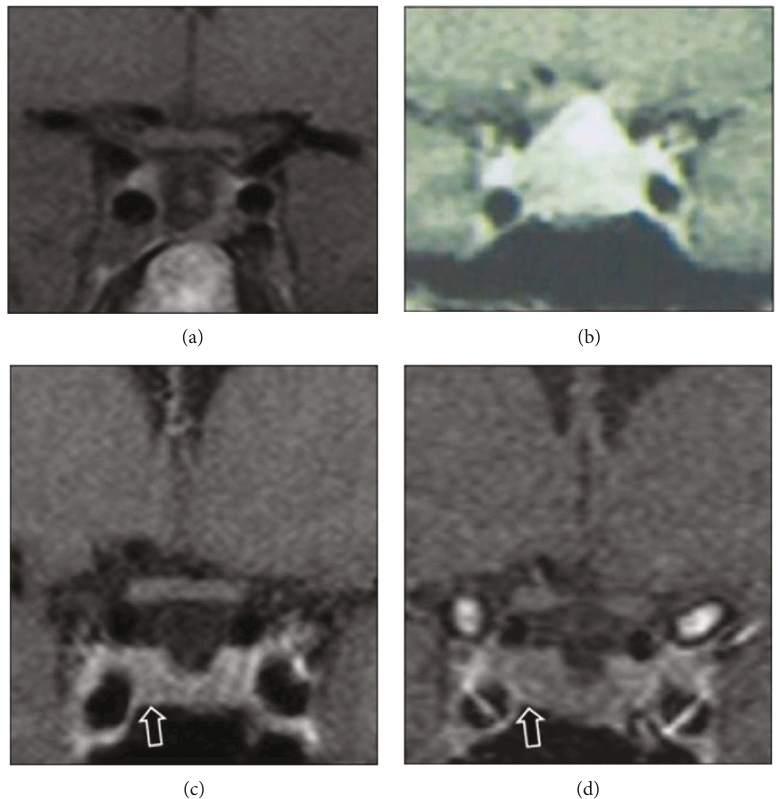
Figure 1: (a) The proband ’ s (case 1) last MRI scan showing a visible thin rim of tissue around the pituitary fossa walls but no recurrent tumour. (b) A pituitary MRI scan of the proband ’ s brother (case 2) at the time of diagnosis, showing a pituitary macroadenoma impinging the optic chiasma. (c) Case 2 ’ s follow-up MRI scan 7 years after the original surgery shows a small 5mm region with reduced enhancement in the right side of the pituitary representing a remnant of the pituitary adenoma, which has recently grown slightly (d) and was